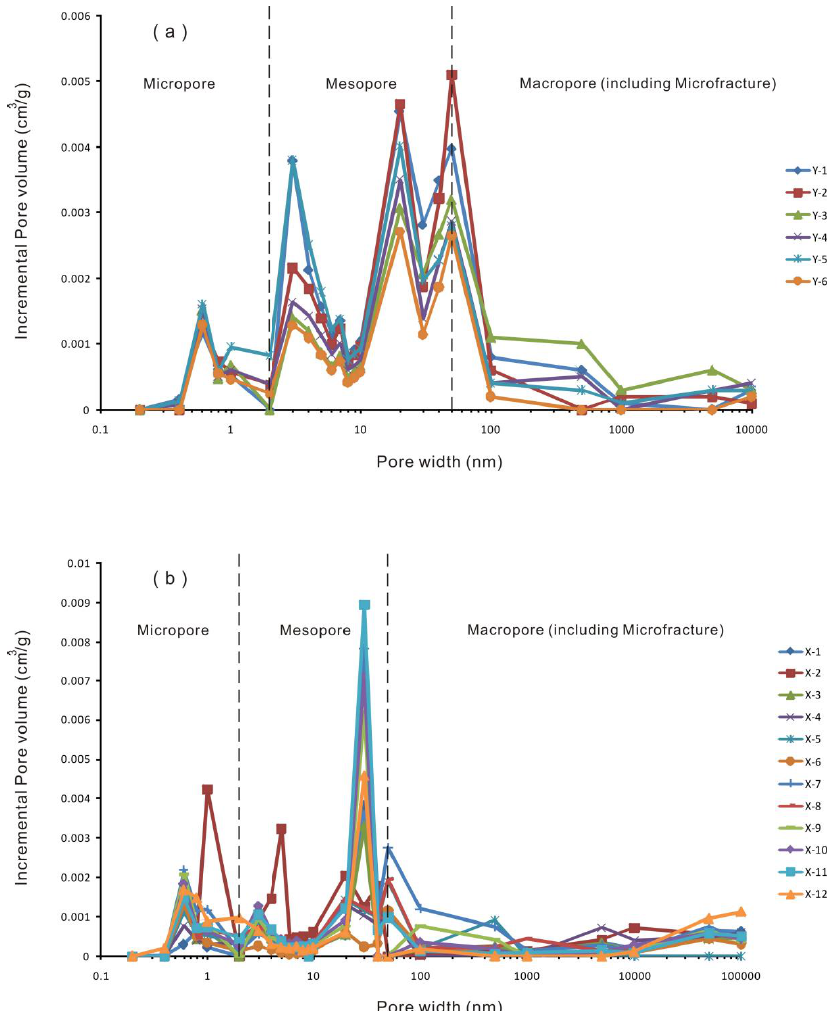
Figure 12. Pore size distribution curves of incremental pore volume of transitional Longtan Shale samples from YV-1 ( a ) and XD-1 ( b ). The boundaries between micropore, mesopore and macropore were highlighted by bold dashed